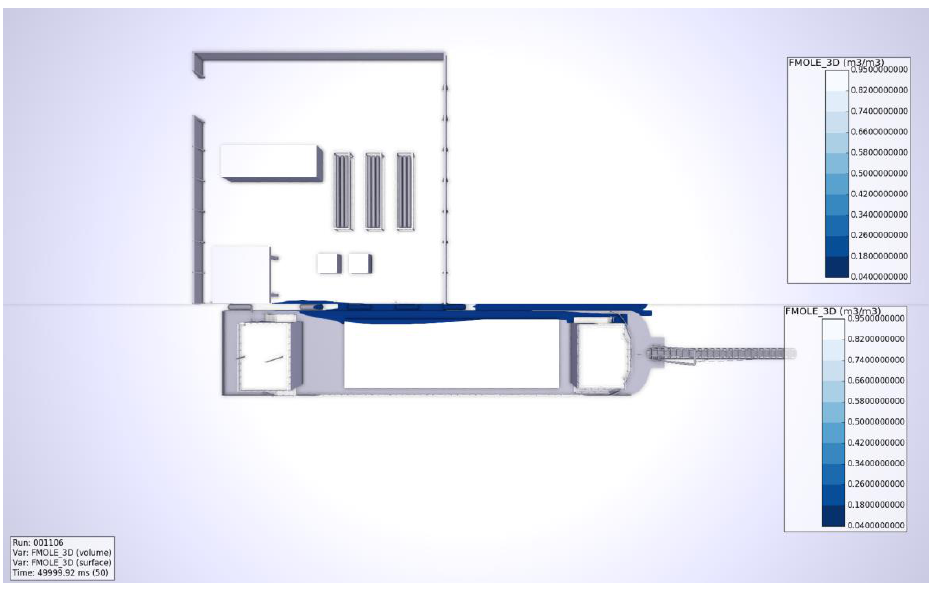
Figure 5. The cross section, longitudinal section and overall diffusion range of hydrogen cloud at different time points after leakage.